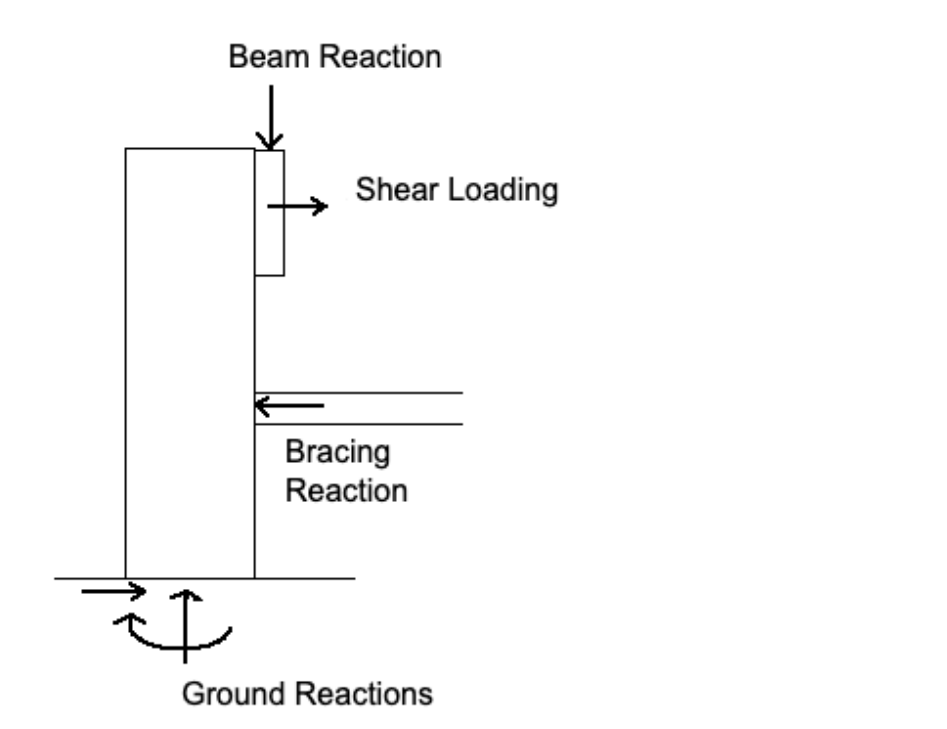
Figure A9. Post Free Body Diagram.